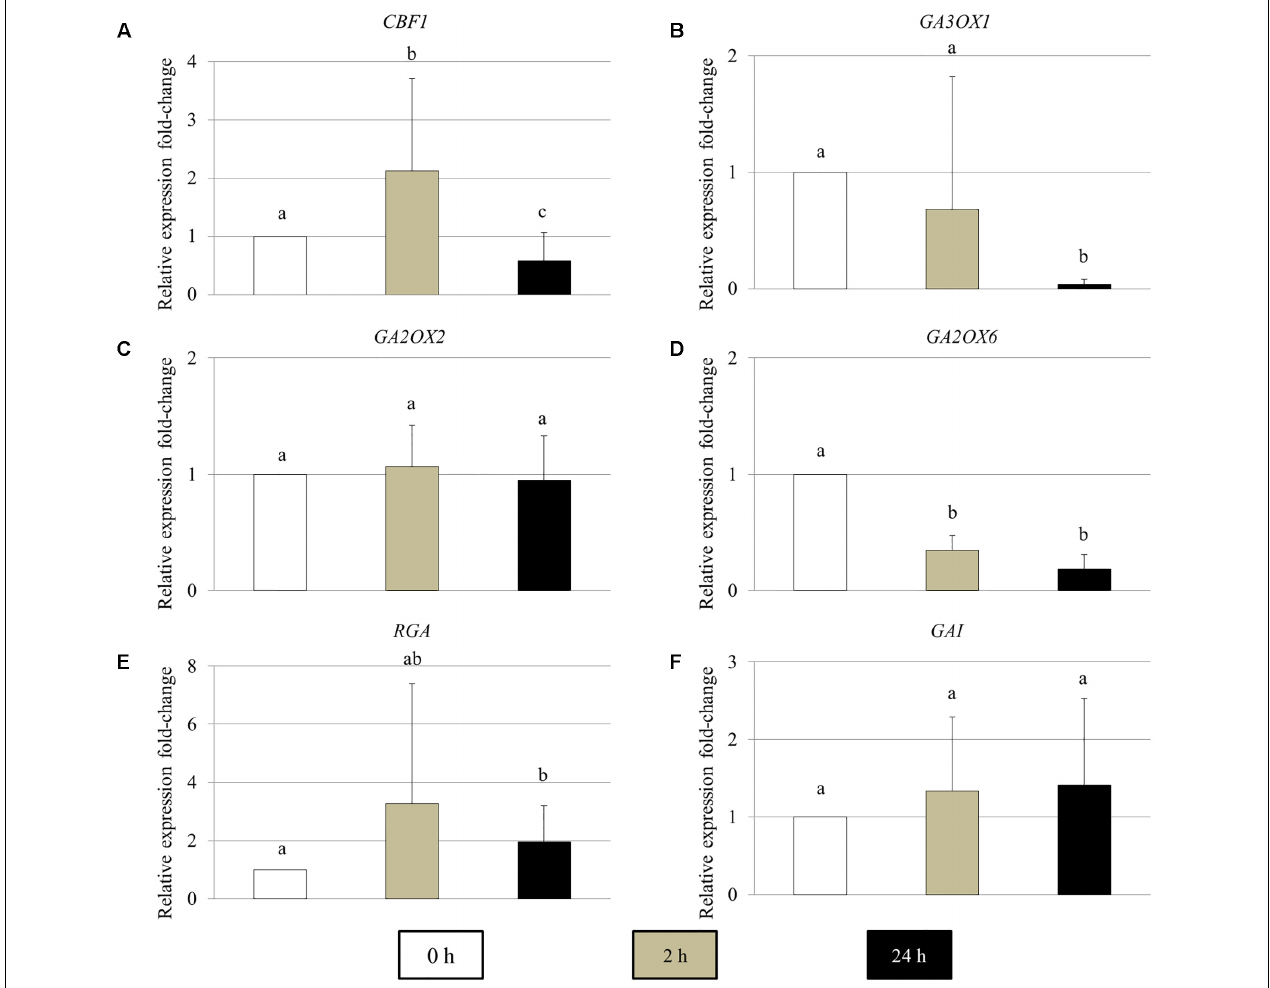
FIGURE 5 | The relative expression fold-change of GA metabolic and signaling genes in Arabidopsis young flower buds under cold stress. (A–F) Histograms showing the relative expression fold-change of CBF1 (A) , GA3OX1 (B) , GA2OX2 (C) , GA2OX6 (D) , RGA (E) , and GAI (F) in early stage Arabidopsis flower buds under cold stress. X axis represents time period under cold treatment; Y axis represents relative expression ratio of the genes. Error bars represent standard deviation with significance level (alpha) =